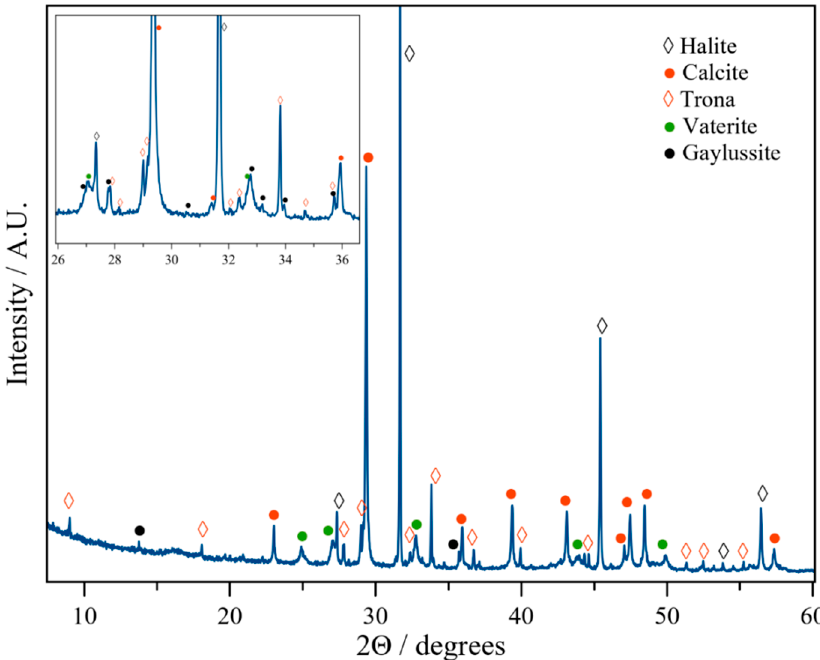
Figure 4. Powder X-ray diffractogram of calcium vesicles .